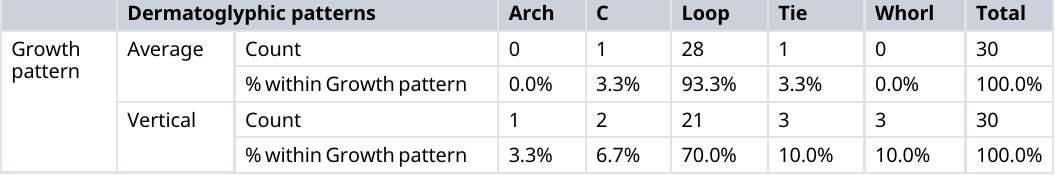
Table 3. The Fisher ’ s exact test between the average and vertical groups (Left hand).